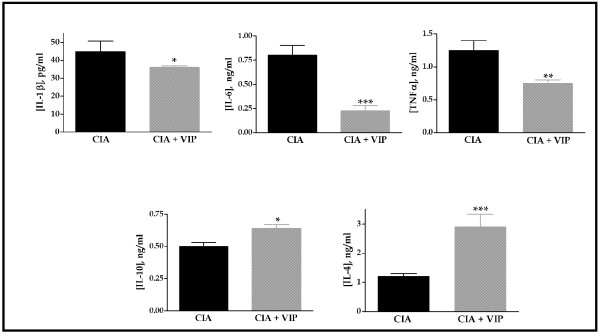
Cytokine circulating levels in mice at the end of treatment in the collagen-induced arthritis (CIA) model. IL-1β, tumor necrosis factor (TNF)α, IL-6, Il-10 or IL-4 were measured (mean ± SEM) by ELISA in arthritic animals and the same animals treated with VIP. On day 10 of VIP treatment, differences between the arthritic group and the CIA group treated with vasoactive intestinal peptide (VIP) were statistically significant (*p < 0.05, **p < 0.01, ***p < 0.001). Results are the mean ± SEM of two separate experiments with 10 animals per group.